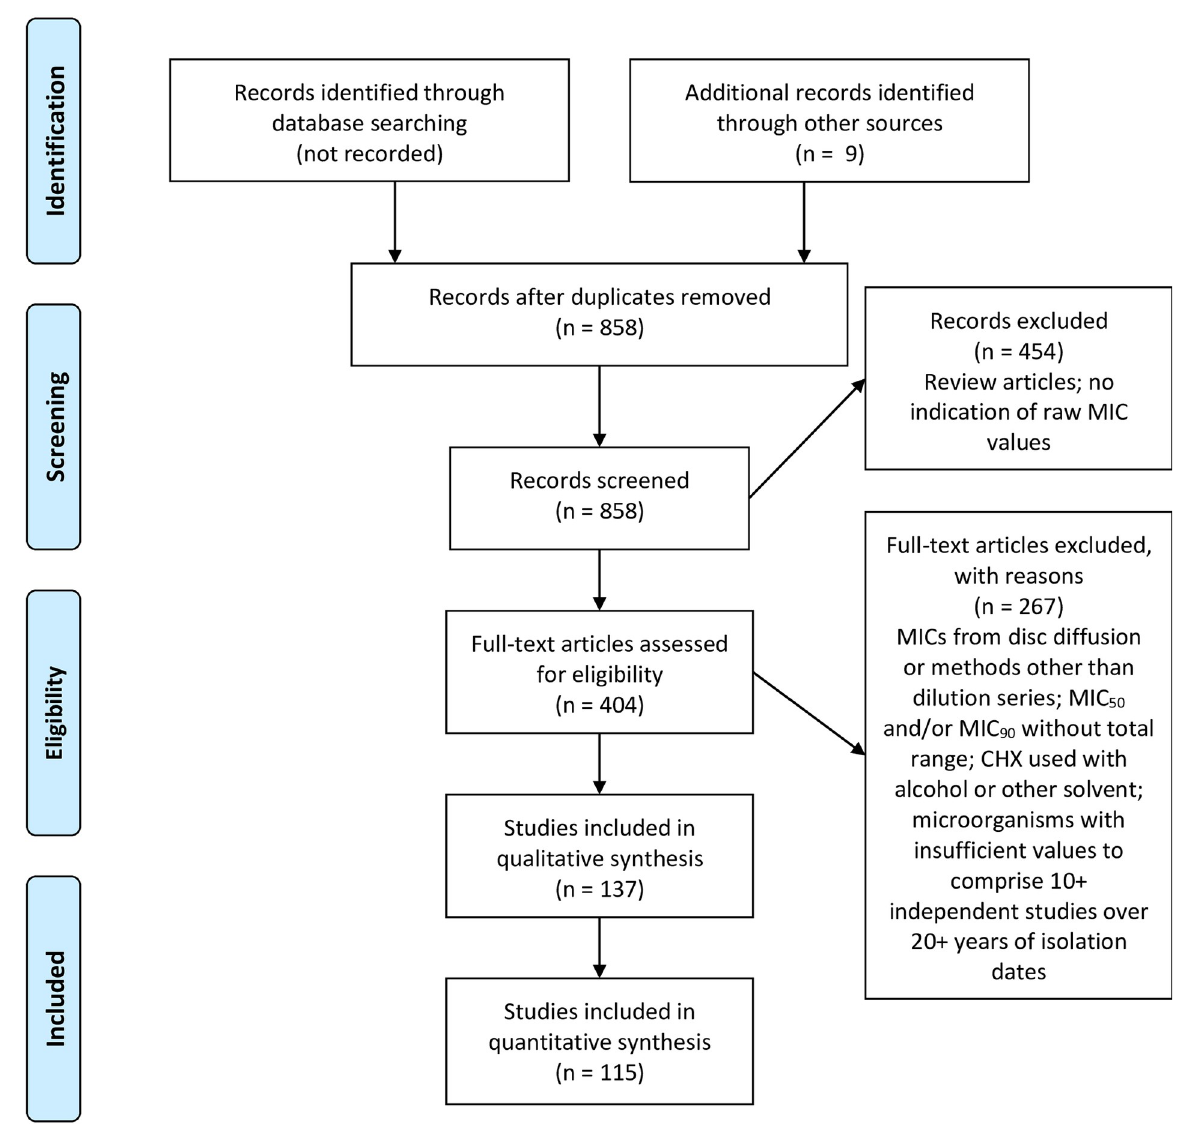
Fig 1. Literature selection